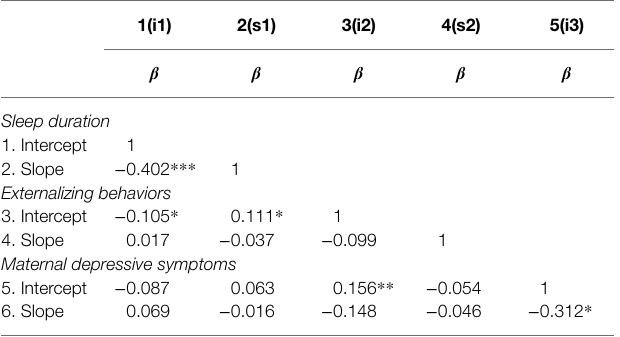
TABLE 6 | Standardized coefficients among growth factors in multivariate growth model 3: sleep problem—externalizing behaviors.